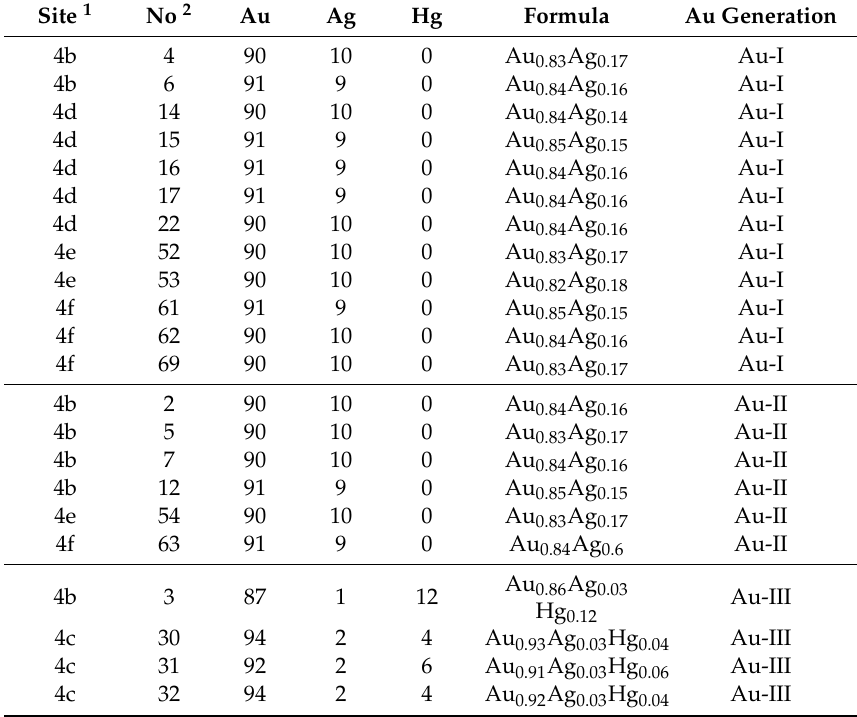
Table 10. “Separated” composition of inclusions of native gold (wt.%) in PGM grain No. 3 (Figure